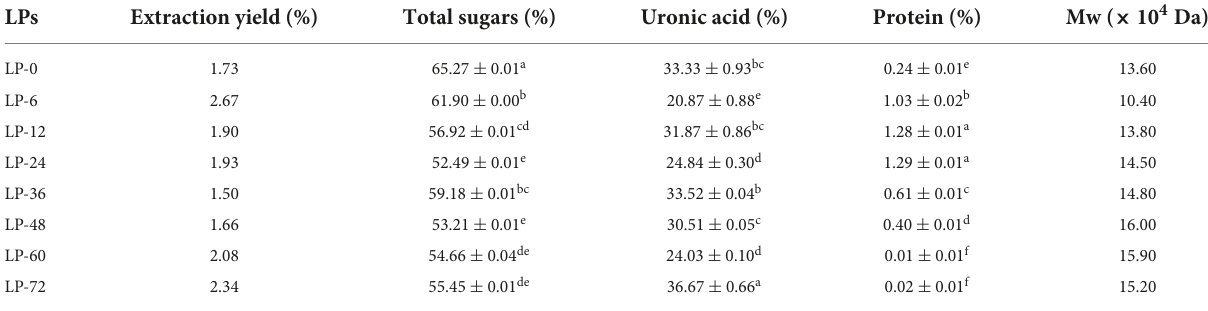
TABLE 1 Physicochemical properties of polysaccharides derived from litchi pulp fermented with Lactobacillus fermentum for different times.